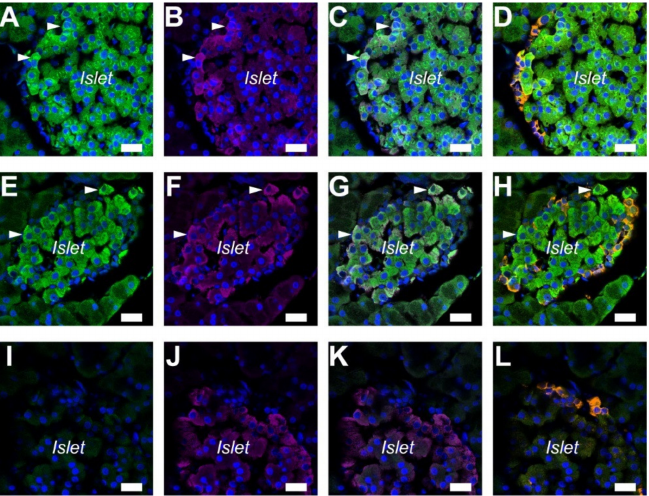
Figure 1. Immunolocalization of A 2A and A 2B adenosine receptors in the pancreatic islets of the rat. ( A ) Fluorescence of A 2A adenosine receptor in the cell membrane (arrowheads). ( B ) Fluorescence image of insulin. ( C ) Overlay image of A and B . ( D ) Overlay of A and fluorescence image of glucagon (orange) in the same sample. ( E ) Fluorescence of A 2B adenosine receptor in cells (arrowheads). ( F ) Fluorescence image of insulin. ( G ) Overlay image of E and F . ( H ) Overlay of E and fluorescence image of glucagon (orange). ( I ) Isotype control image of the rat pancreas with normal rabbit IgG (2 µ g / mL). ( J ) Fluorescence image of insulin. ( K ) Overlay image of I and J . ( L ) Overlay of I and fluorescence image of glucagon (orange). 4 (cid:48) ,6-diamidino-2-phenylindole (DAPI) was used to stain nuclei (blue). Representative images of three rats are shown. Bars = 20 µ